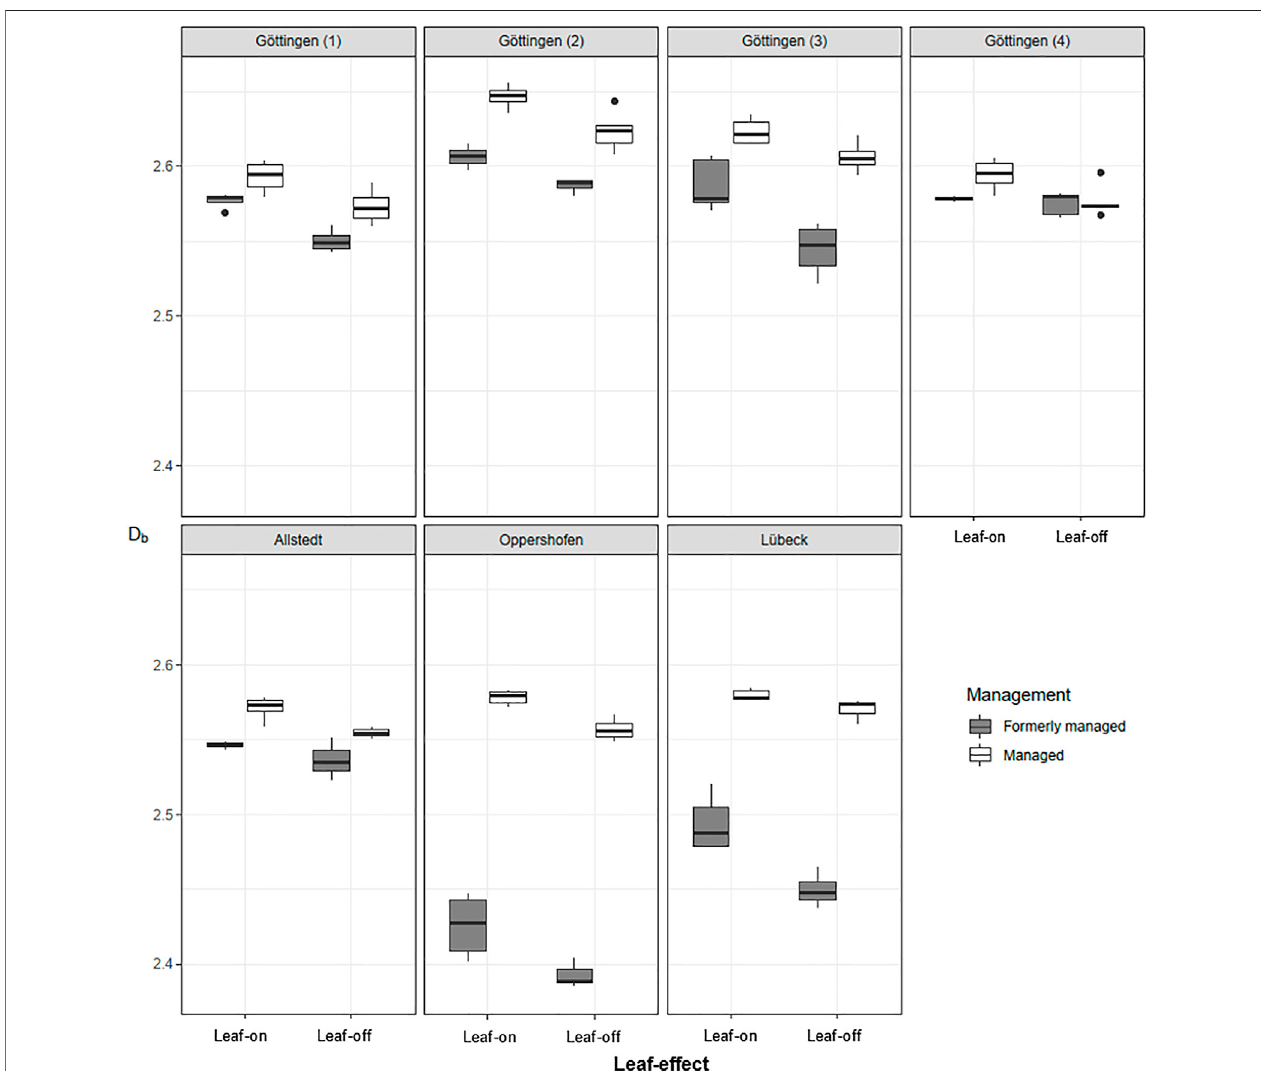
FIGURE 4 | Box-Whisker plots of stand structural complexity, expressed as box-dimension (D b ), in leaf-on and leaf-off conditions for all 14 study plots and shown separately for the managed and unmanaged sites in each area. We omitted testing for signi fi cant differences for individual plots with regard to the leaf-effect and the management due to small sample